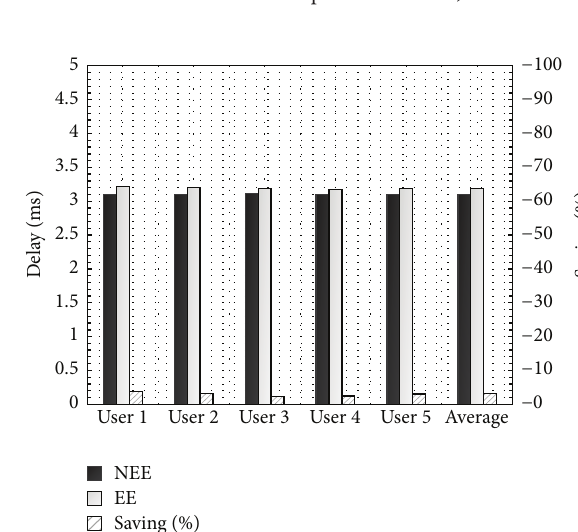
Figure 5: User (VNF) delays with 𝑆 = 3, 𝑁 = 5.